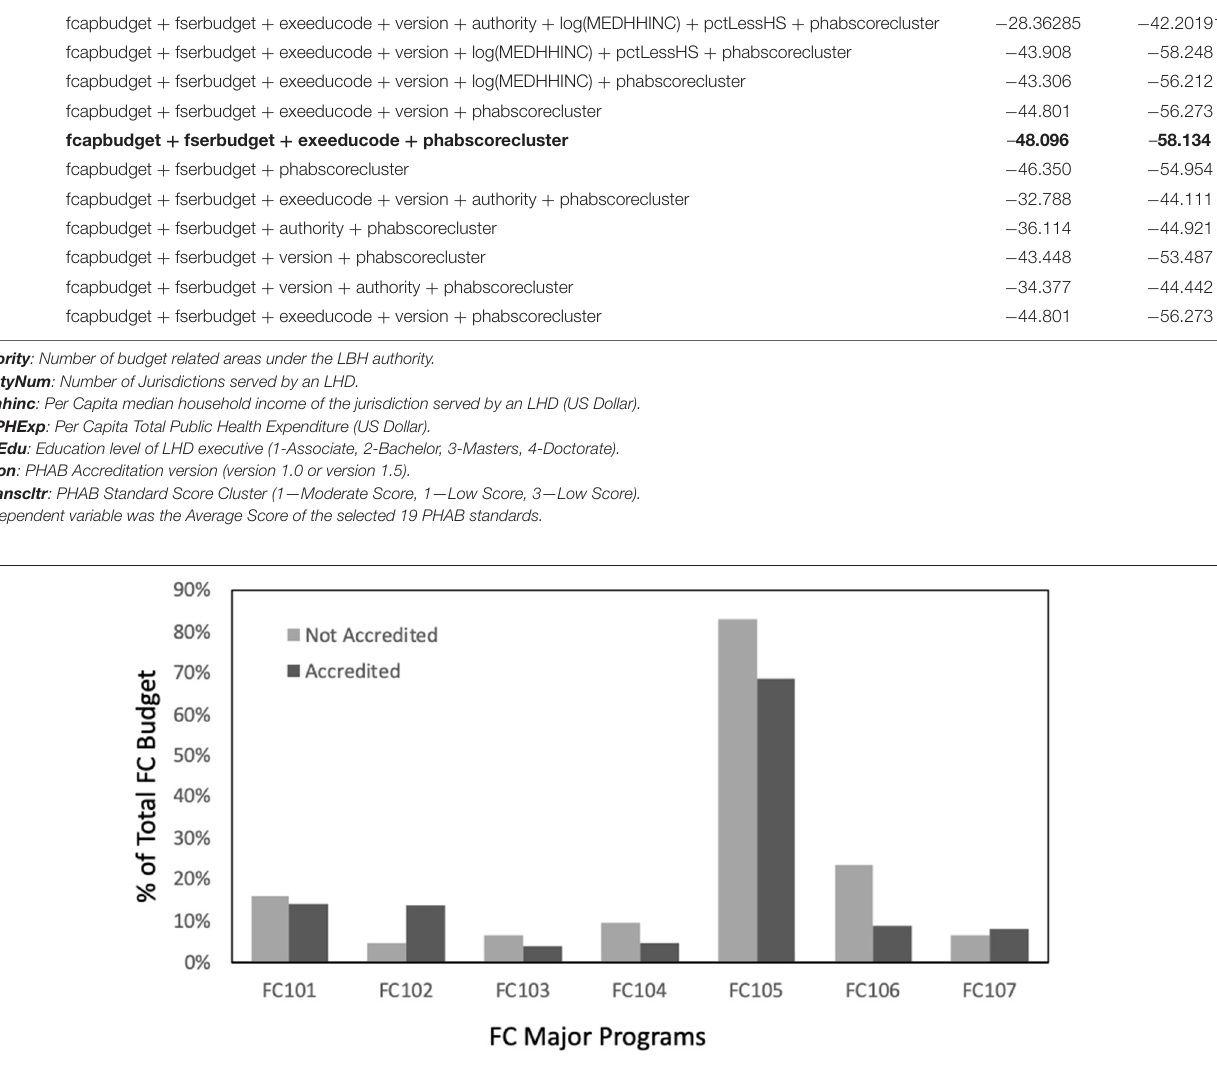
TABLE 2 | Model variable selection with BIC and AIC diagnostics. Model